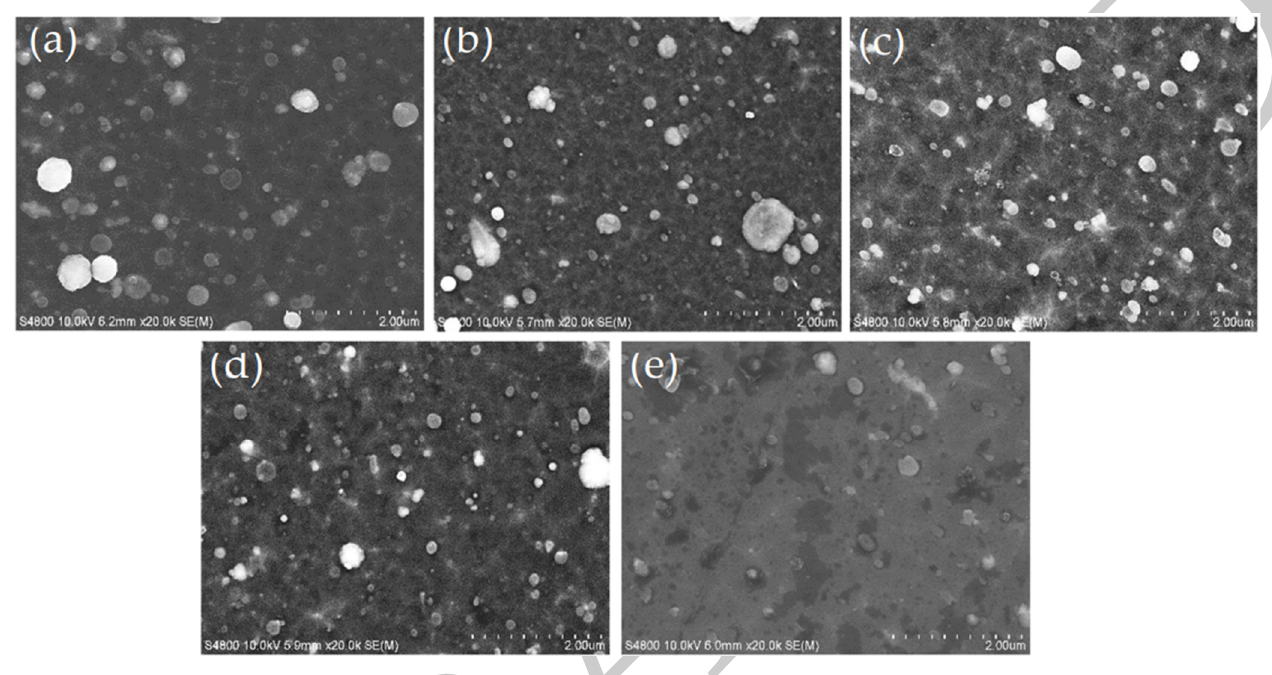
Figure 3. Surface morphologies of the AlCrTiSiN coatings before and after annealing. ( a ) as-deposited,